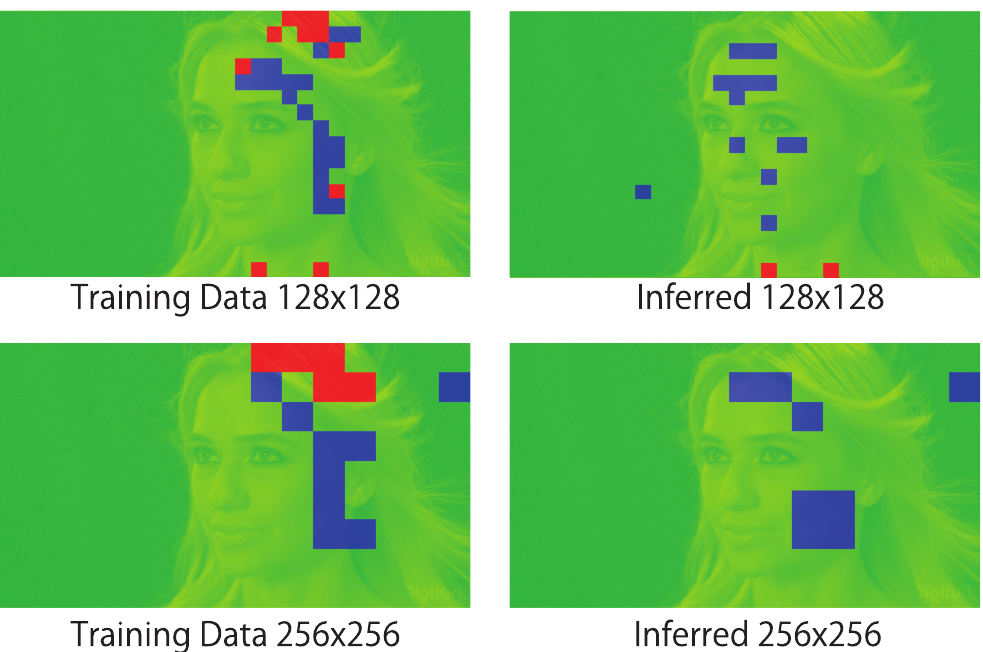
Figure 9. Comparisons among distributions of compression programs used for training and inferred by DNN (Beauty).